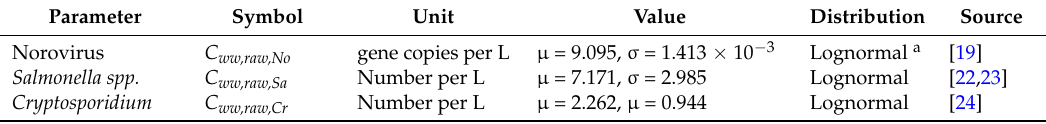
Table 2. Monte Carlo simulation input parameters for pathogen